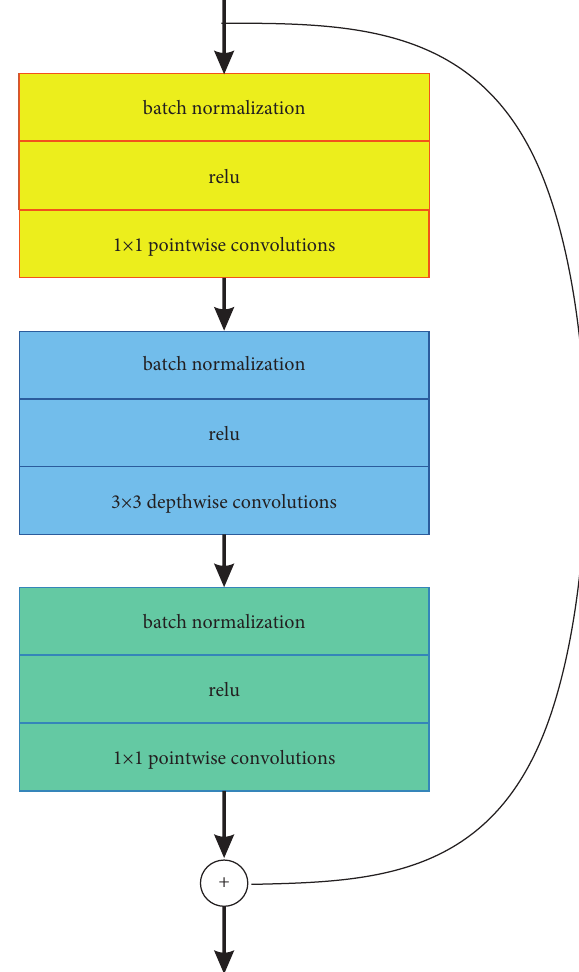
Figure 5: Structure of the inverted residual block [20]. The 1 × 1 convolutions were added before depthwise convolutions to expand the dimensions of the input matrix. In this structure, we used full